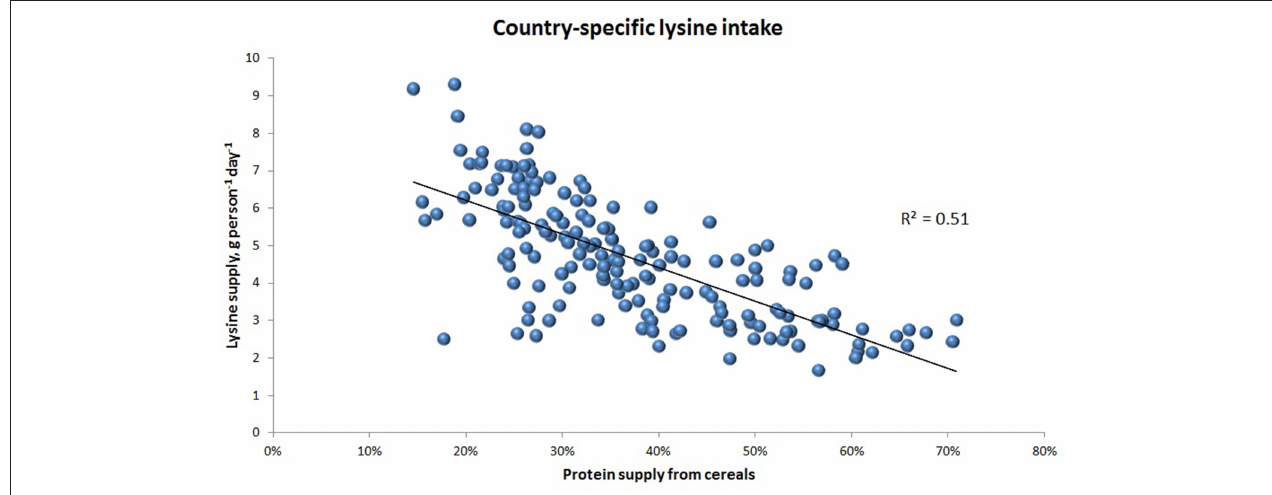
FIGURE 4 | Empirical relationship between the proportion of cereal-based proteins in the protein supply and the daily per person lysine supply in different countries. Based on the FAOSTAT (2018) food supply data and the USDA (2018) nutrition